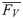
Parametric finite element model of the functionally graded scaffold utilized in the study.CAD model (A-B) and finite element mesh (C-D) of the scaffold (A, C) and granulation tissue (B, D). Circular pores with variable radius A have been modelled. The nodes of the bottom surface of the model were clamped (E-G) while those of the upper surface were tied to a rigid plate (represented in blue). Three different loading conditions were hypothesized: a compression force FV¯ (E); a shear force FH¯ (F); a mixed compression-shear force FM¯ (G). The pore pressure ppore on the outer surfaces of the granulation tissue was set equal to zero to simulate the free exudation of fluid.